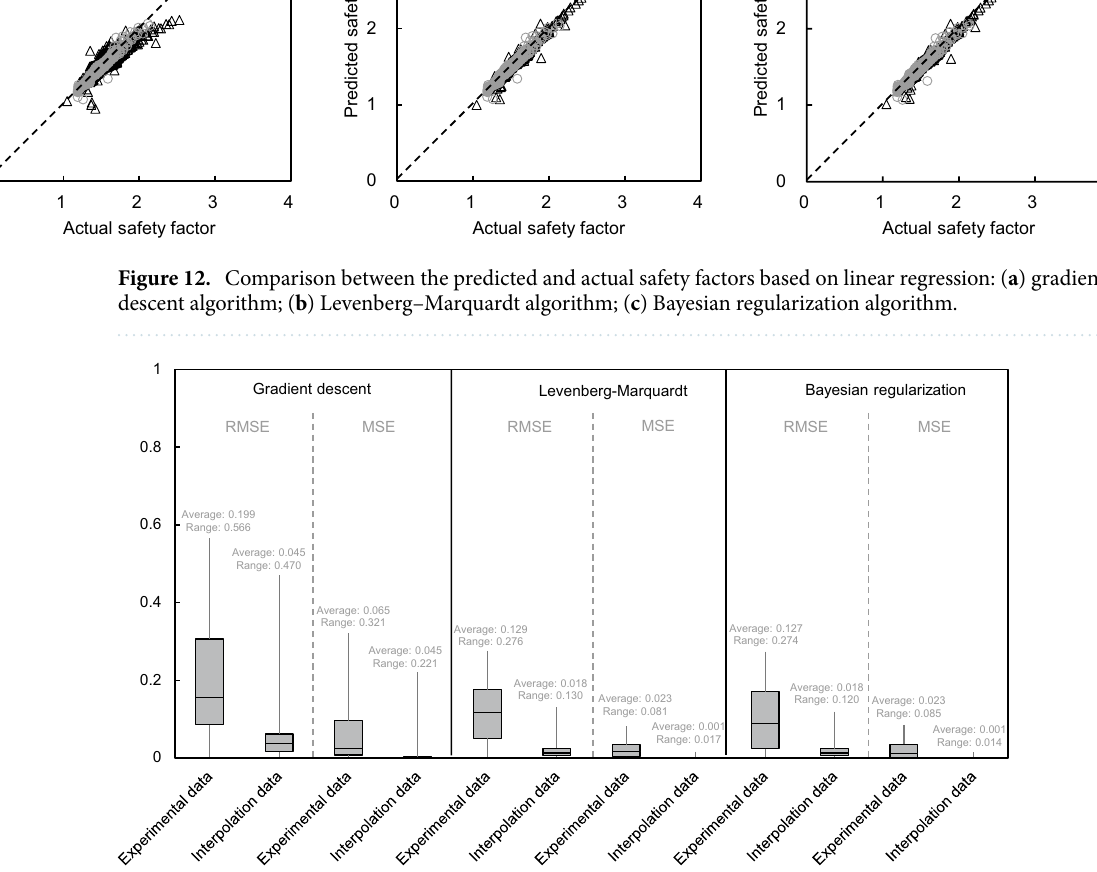
Figure 13. Distribution of root mean square error (RMSE) and mean square error (MSE) based on linear